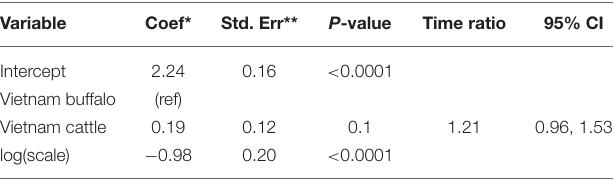
TABLE 3 | Generalized linear mixed model for the probability of FMDV RNA recovery from oropharyngeal fluid following an FMD outbreak in Vietnam. Variable